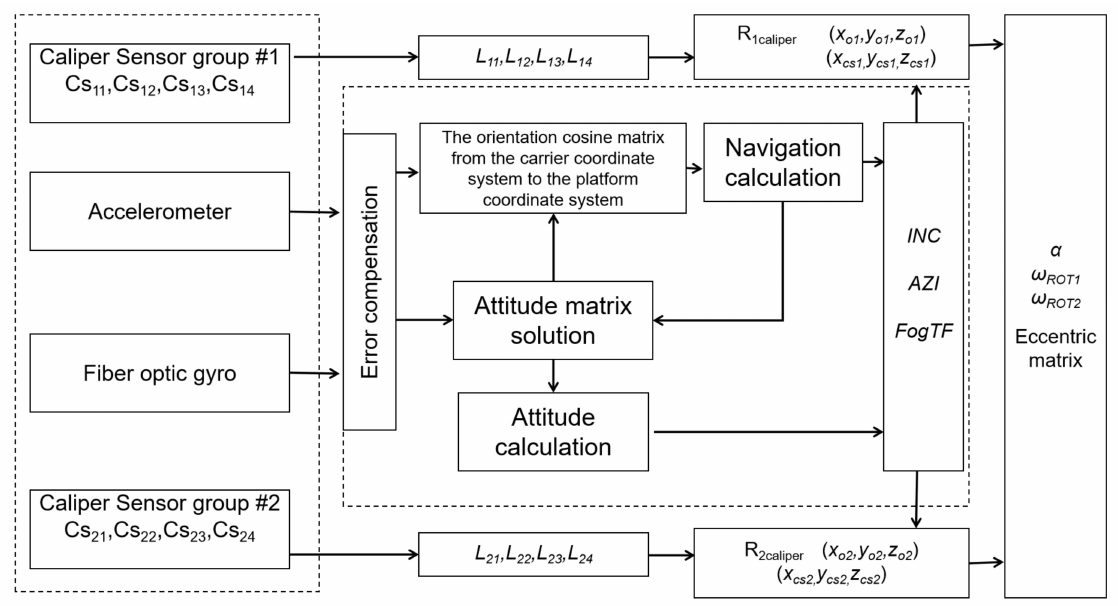
Figure 5. Schematic diagram of the multi-sensor layout of the drill string eccentricity measurement data